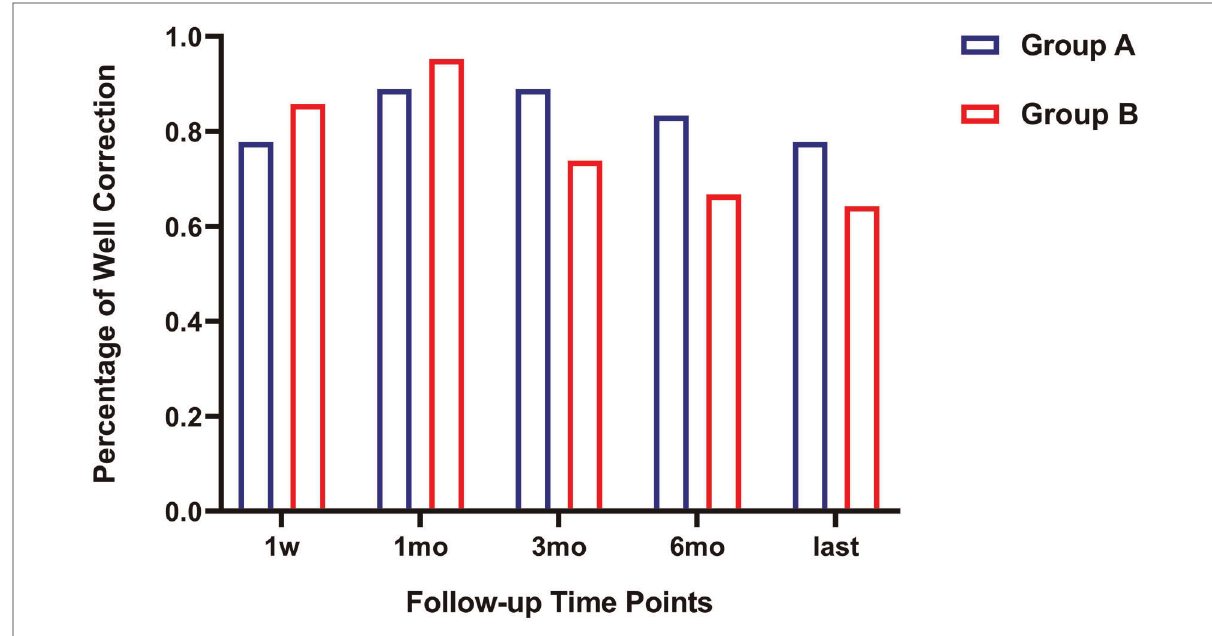
FIGURE 2 Comparison of corrective effect between two groups at different follow-up points.